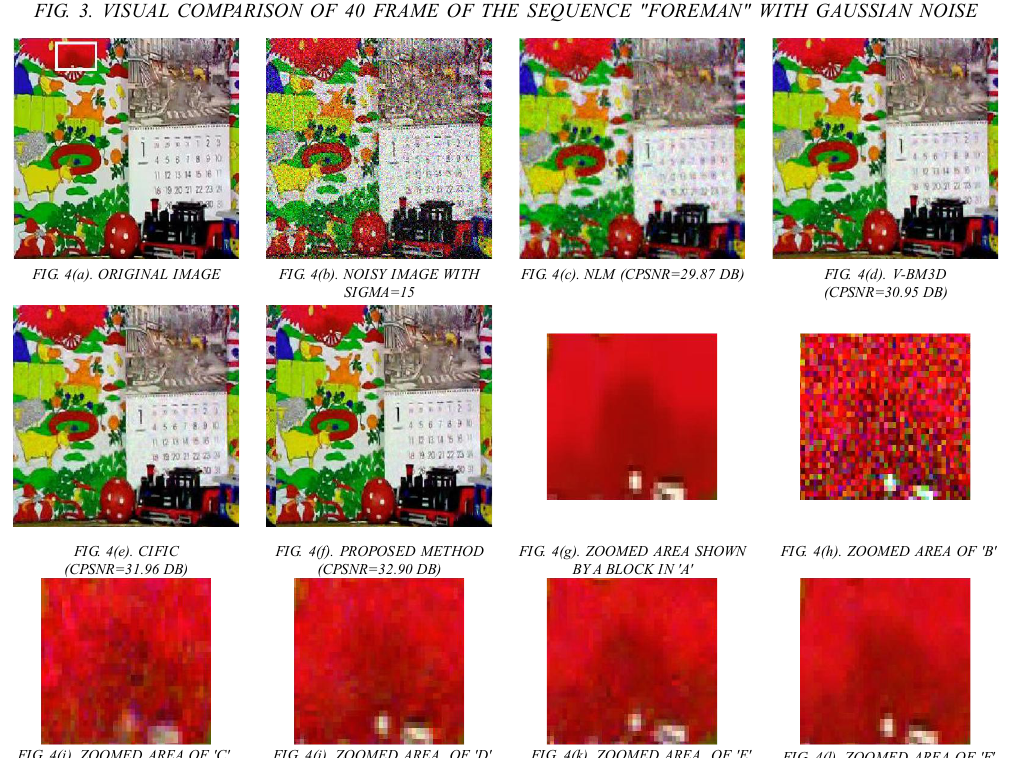
FIG. 3(j). SAME ZOOMED AREA OF 'D' FIG. 3. VISUAL COMPARISON OF 40 FRAME OF THE SEQUENCE "FOREMAN" WITH GAUSSIAN NOISE